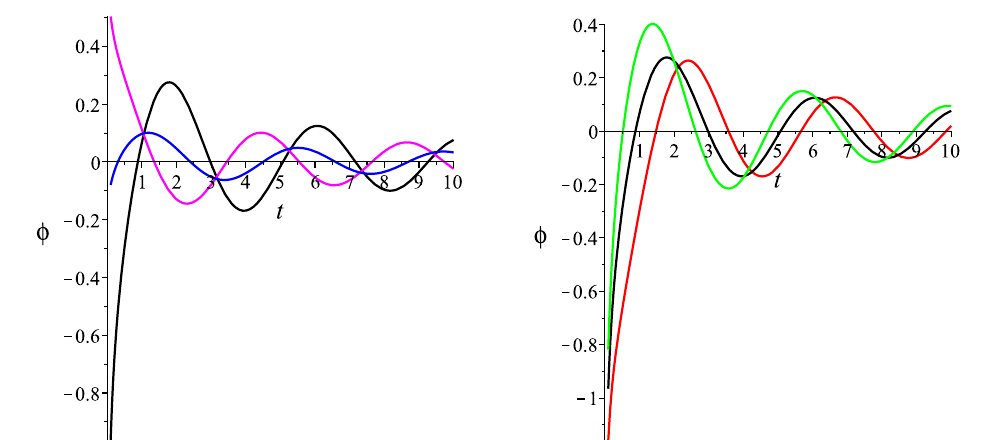
. On the left , C u 1 ; 2 = 2 (magenta line). On the right , C u 2 = 1 (black line) and C u 1